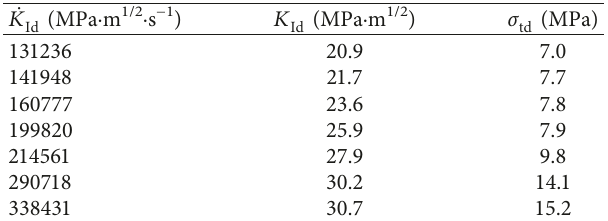
Table 6: Dynamic fracture toughness and dynamic tensile strength of